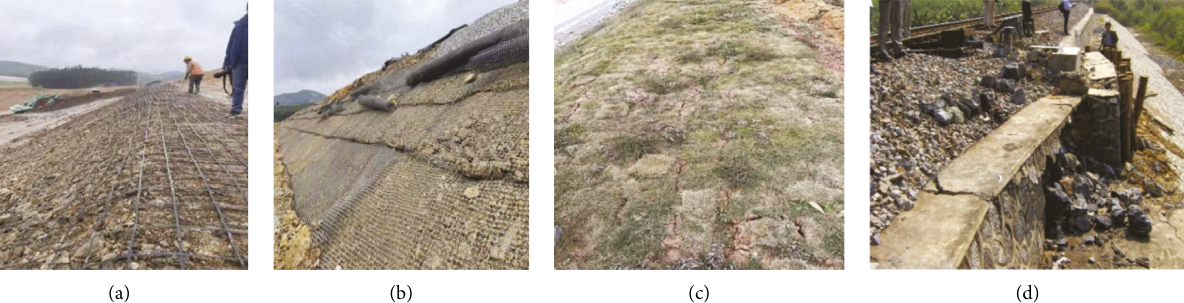
Figure 2: Flexible support of expansive soil and problems after support application. (a) Geogrid. (b) Waterproof material. (c) Cracking after flexible support. (d) Rigid support failure. Table 1: Classification of expansive soil filler materials (if w Filler